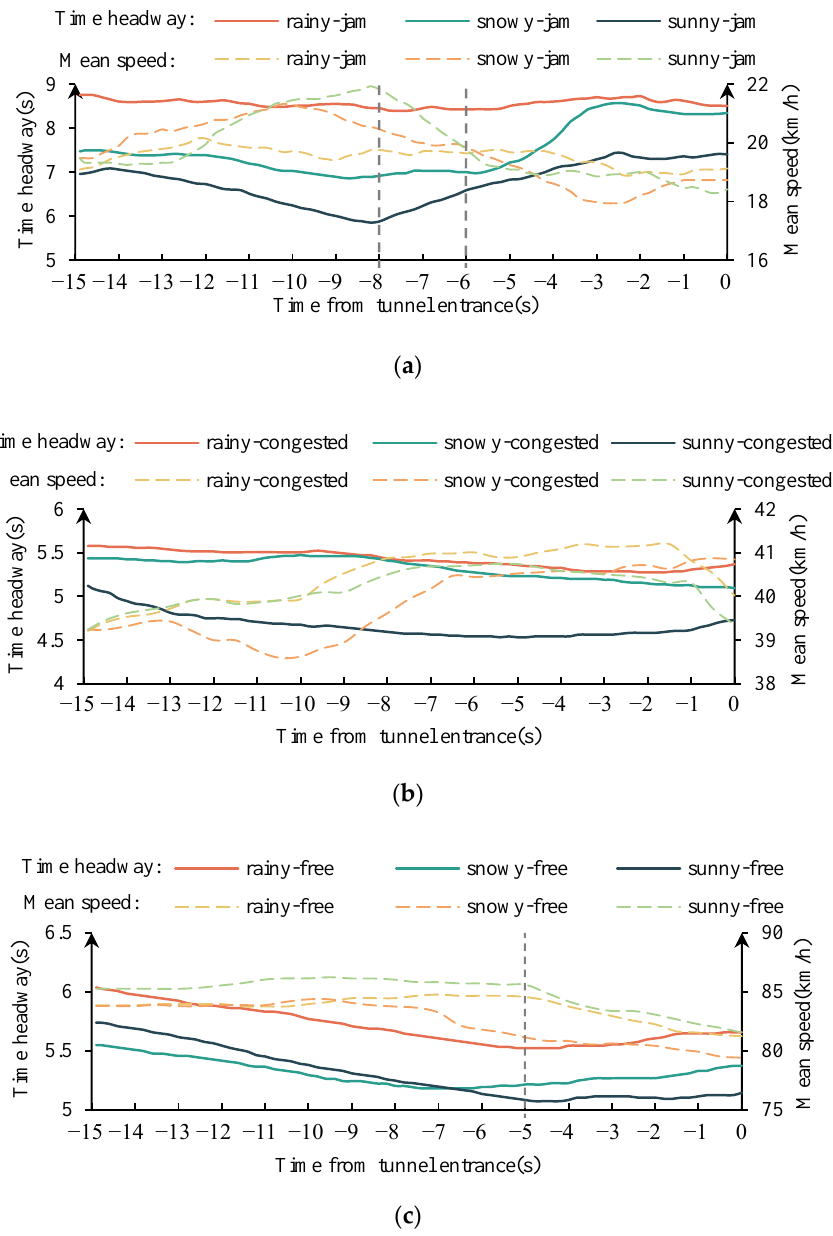
Figure 9. The mean change of the time headway within 15 s from the tunnel entrance. ( a ) jam flow condition. ( b ) congested flow condition. ( c ) free flow condition.